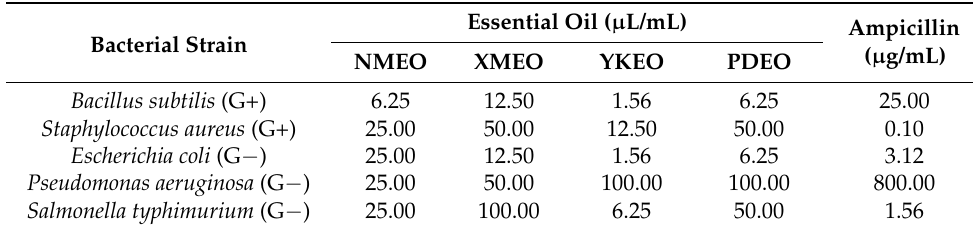
Table 3. Minimum inhibitory concentrations